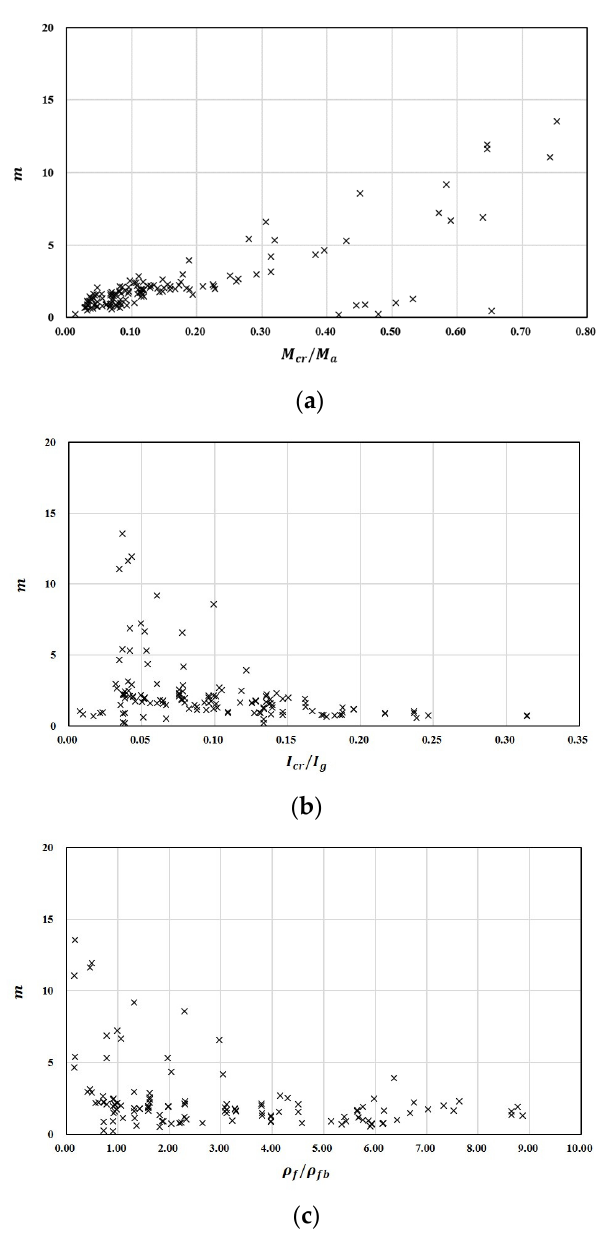
Figure 2. Relationship of m versus influence factor: ( a ) 𝑀 (cid:3030)(cid:3045) /𝑀 (cid:3028) ; ( b ) 𝐼 (cid:3030)(cid:3045) /𝐼 (cid:3034) ; ( c ) 𝜌 (cid:3033) /𝜌 (cid:3033)(cid:3029) .